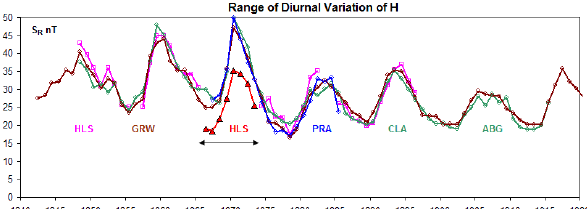
Figure A6. The diurnal range (in nT) of the horizontal force for Prague (PRA) blue, Colaba (CLA)+Alibag (ABG) green, Greenwich (GRW) brown, and Helsinki (HLS) pink. For the interval 1866–1874, HLS (red triangles) is clearly seriously too